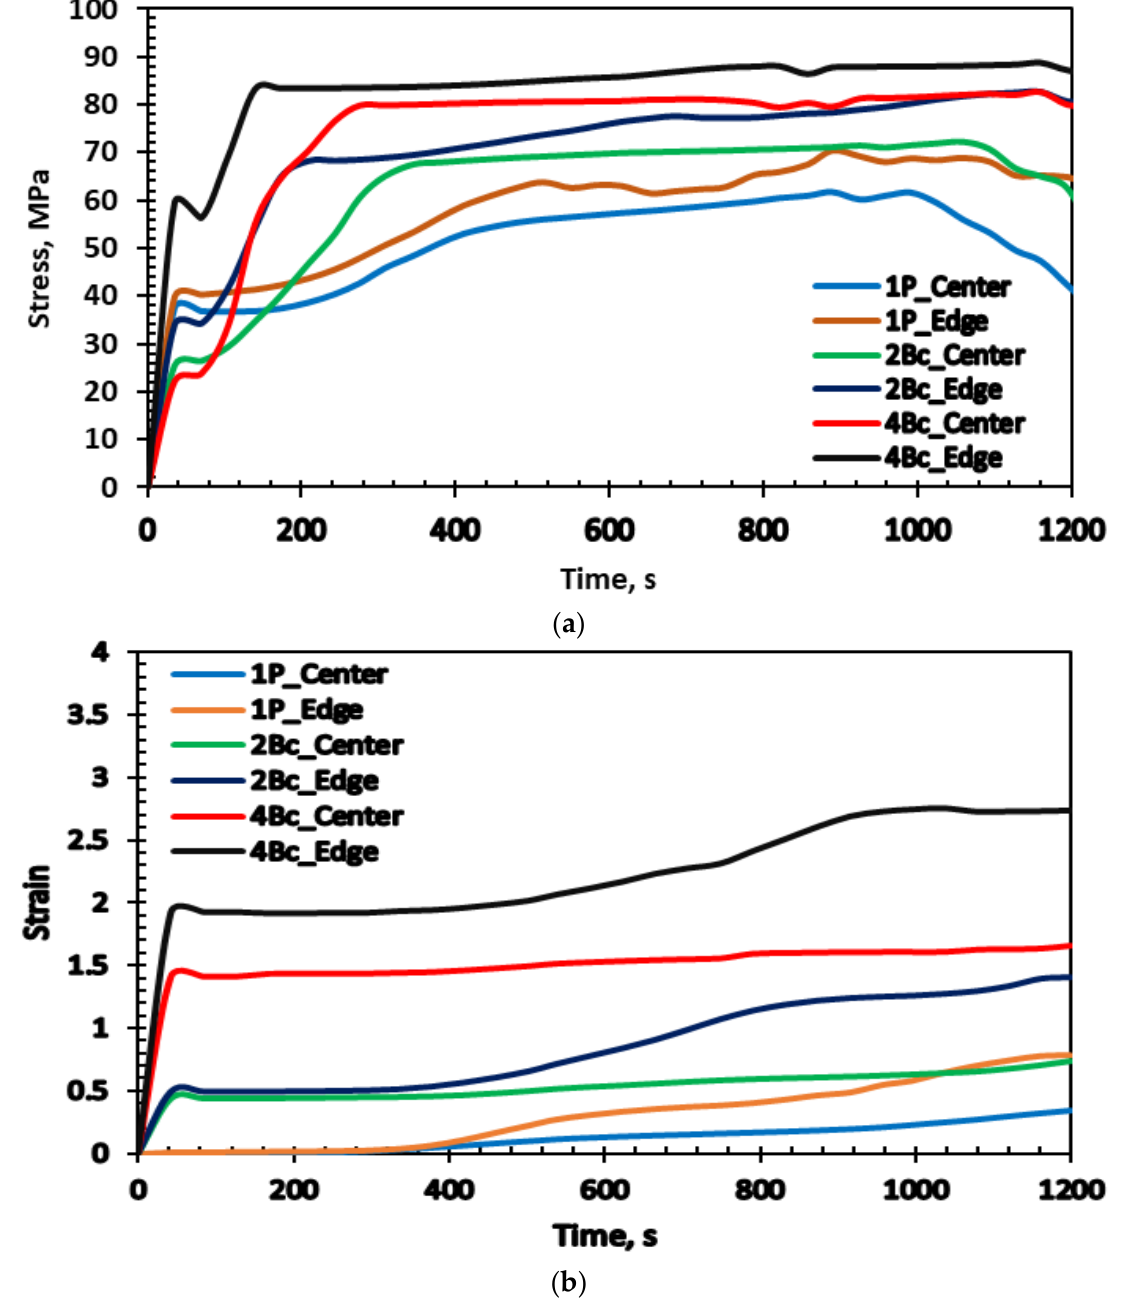
Figure 8. Stress versus time ( a ) and strain versus time ( b ) at the central and peripheral regions of AA2011 processed through 1- p , 2-Bc, and 4-Bc at 150 º C.